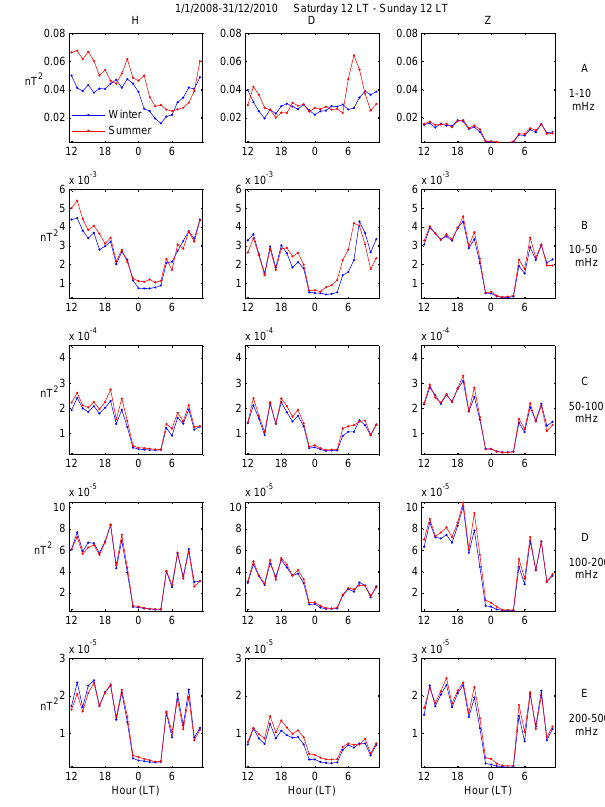
Figure 2. The traces of daily variation of the hourly-average power values for the entire week as evaluated for the whole period 2008– 2010 in the different frequency bands for winter (November–March, blue line) and summer months (April–October, red line). The sum- mer trace has been shifted 1h to take into account the daylight sav- ing time hour. To provide the same visual representation for equal relative variations, the same ratio (30) between the ordinate limits has been adopted for all panels.